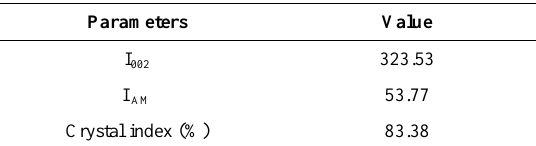
Table 3. Crystal index of cellulose from